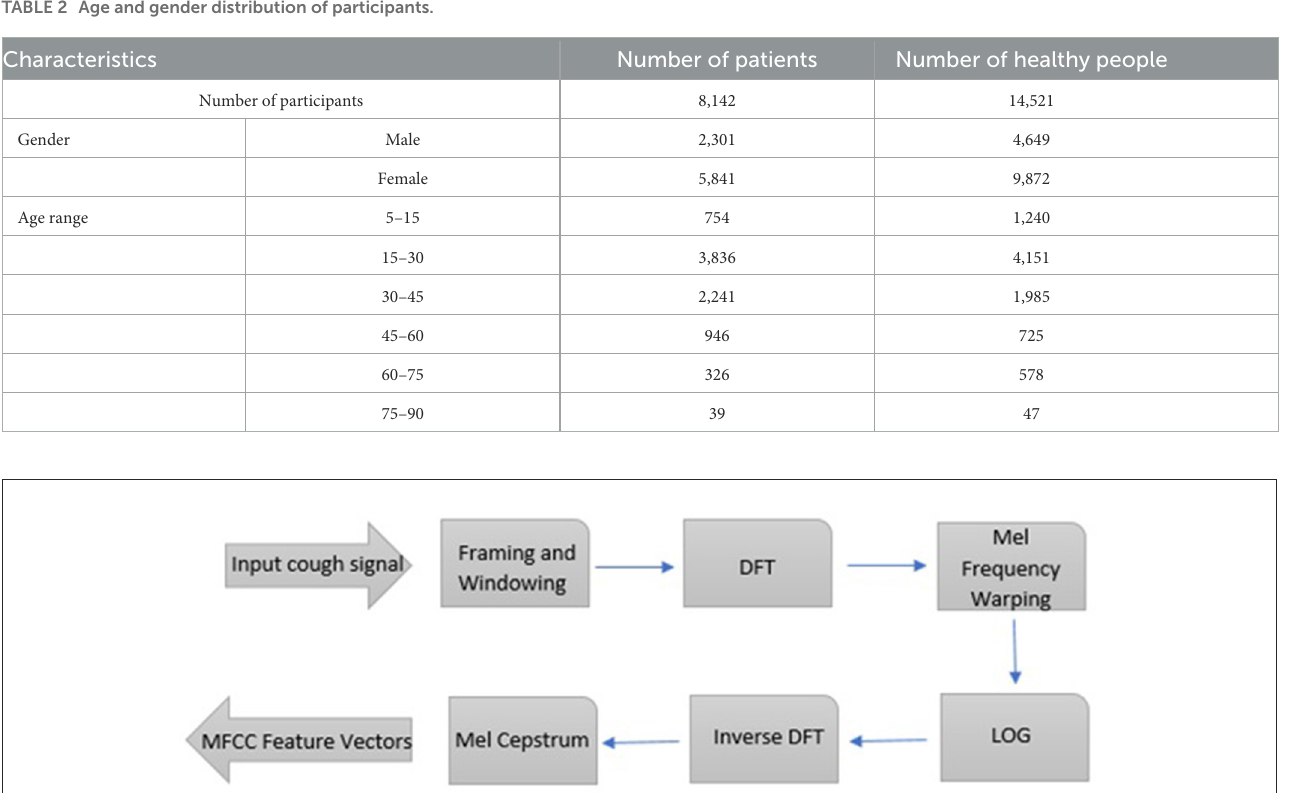
TABLE 2 Age and gender distribution of participants.